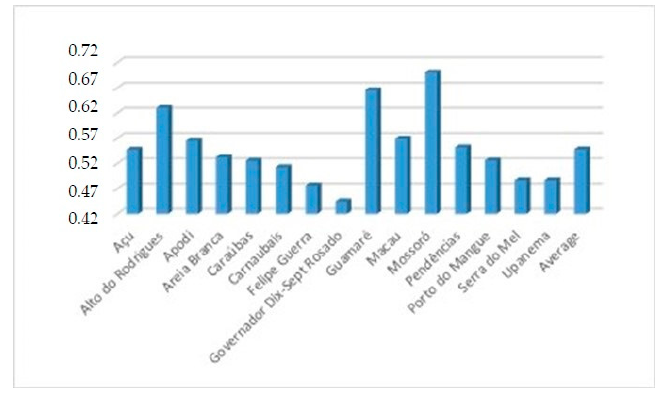
Figure 5. Average IFDM.